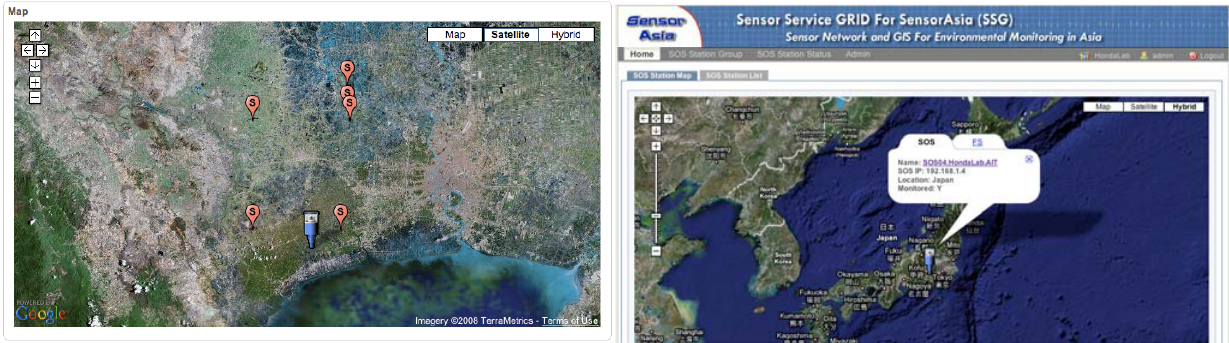
Figure 5. SSG showing the remote field location of SOS Station on Web GIS map.